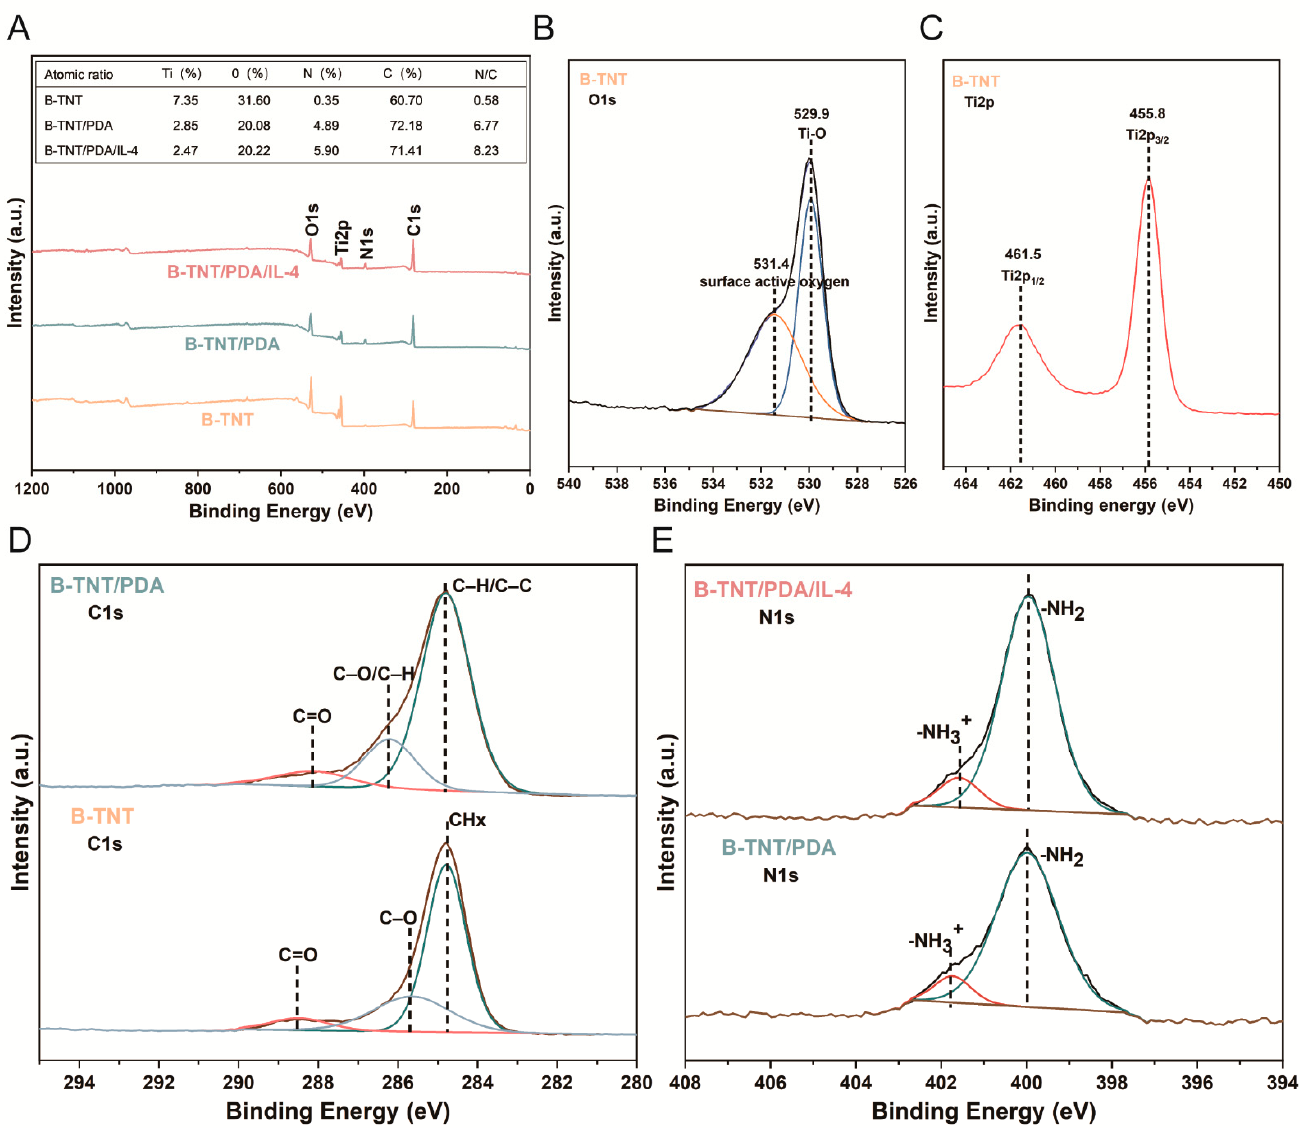
Figure 4. ( A ) Quantification of surface element composition and X-ray photoelectron spectroscopy (XPS) full-scan spectra of B-TNT, B-TNT/PDA and B-TNT/PDA/IL-4 surfaces. ( B ) XPS narrow-scan spectra of O1s for B-TNT surface. ( C ) XPS narrow-scan spectra of Ti2p for B-TNT surface. ( D ) XPS narrow-scan spectra of C1s for B-TNT and B-TNT/PDA surfaces. ( E ) XPS narrow-scan spectra of N1s for B-TNT/PDA and B-TNT/PDA/IL-4 surfaces.